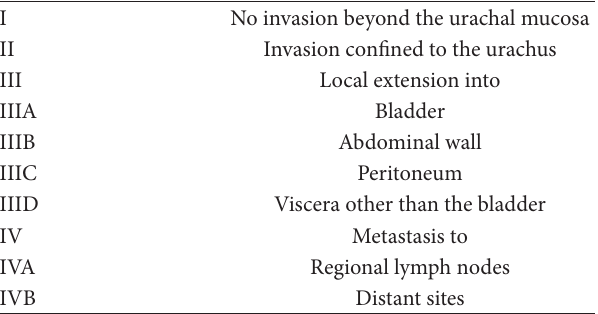
Table 1: Sheldon staging system.